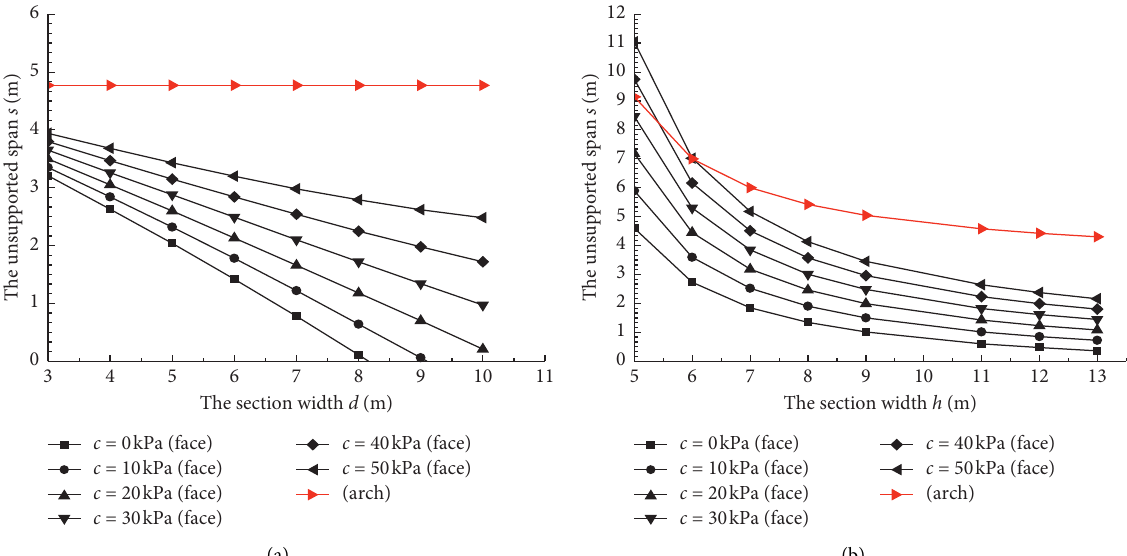
Figure 12: Curves of correlation between the unsupported span and sectional dimension. (a) The section width d. (b) The section height h.